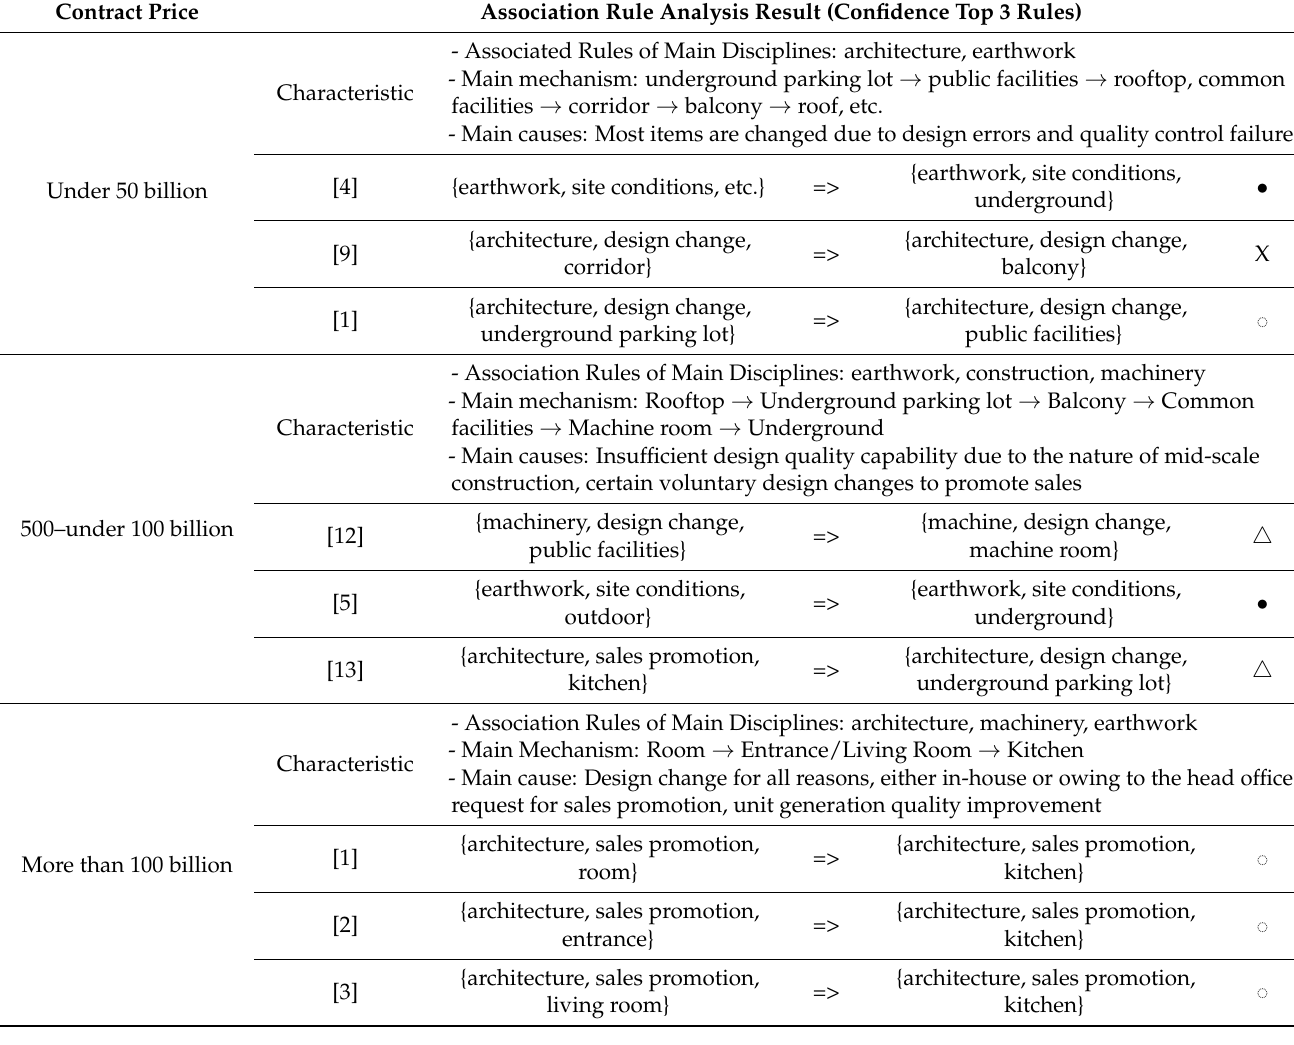
Table 3. Association rule classification system through expert interview.